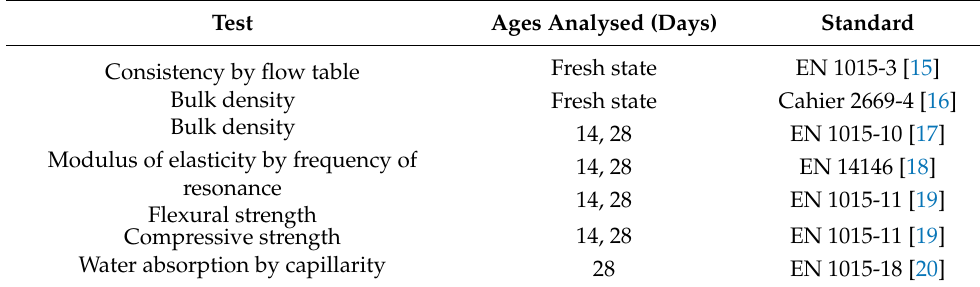
Table 2. Mortars characterization